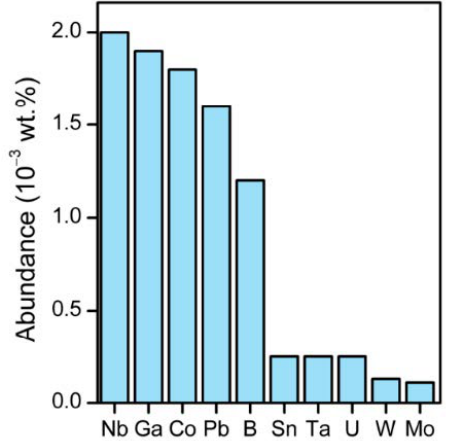
Figure 2. Elements less abundant than niobium in the earth’s crust. The data were obtained with permission from reference [10]. Copyright 2014 Royal Society of Chemistry.Currently, three companies explore niobium in Brazil: the Brazilian Company of Metallurgy and Mining (CBMM), Anglo American Brazil Ltd.@ (Mineração Catalão Goiás), and Mineração Taboca (Paranapanema Group). Brazil contains 98% of the known reserves of niobium in the world, which corresponds to 842.46 million tons [8,9]. The largest Brazilian reserves of niobium are accumulated in pyrochlore ores in the Araxá city, state of Minas Gerais. The ferroniobium alloy is produced through a partnership, of which Minas Gerais Economic Development Company (Codemig) is a participating partner and CBMM is an ostensible partner, whose majority shareholder is the Moreira Salles group. Niobium is the third most exported element in terms of value, losing only to iron ores and gold [11]. The world niobium consumption has grown a hundredfold since